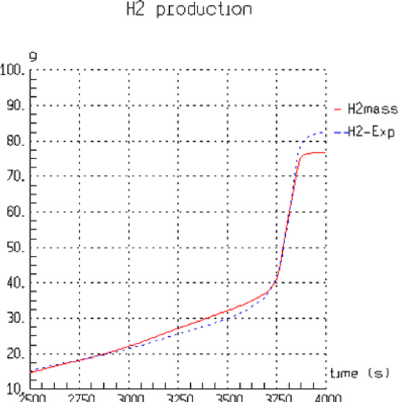
Fig. 8. Example of ASTEC validation vs. the QUENCH-08 re fl ooding experiment (cid:1) hydrogen production in the bundle (@KIT,